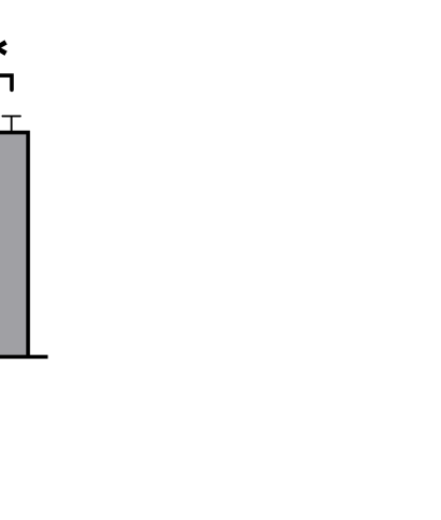
Figure 5. When stress is induced by hypoxia, all Annelida included in our study showed a rise in the levels of polyP. The effects of hypoxia in the levels of mitochondrial polyP were also assayed in our samples. However, no major differences were found in M. solifugus and the other mesophilic counterparts. Data are expressed as mean ± SEM of, at least, three independent experiments conducted using biological triplicates. Values of p ≤ 0.05 were considered significant (** p ≤ 0.01).